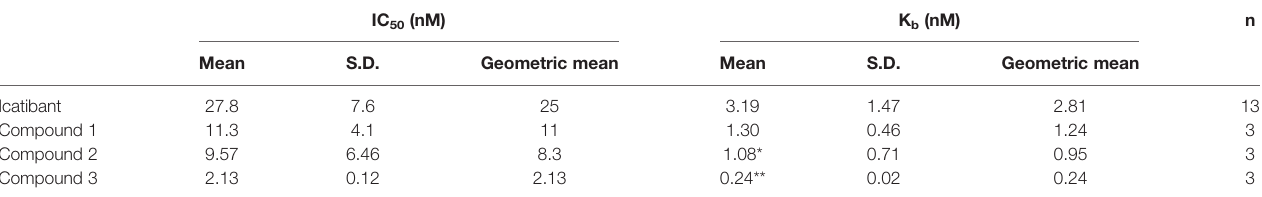
TABLE 2 | Antagonist potencies, IC 50 and K b values at the human B 2 receptor in the calcium mobilization